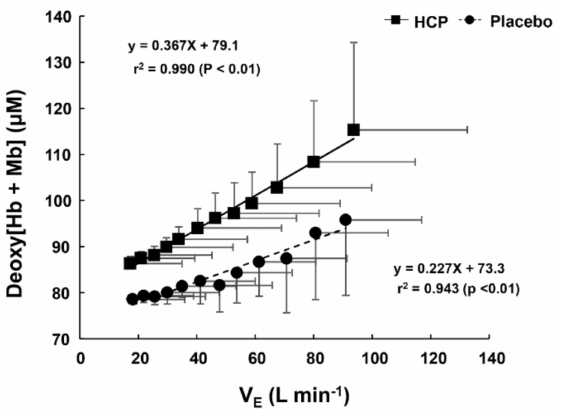
. Figure 4. The relationship between ventilation ( V E ) and the rectus femoris (RF) muscle deoxygenated hemoglobin and myoglobin concentration (deoxy[Hb + Mb]) profiles during cycle exercise in the . HCP and placebo groups. Note that the regression line for V E –deoxy[Hb + Mb] profiles’ relationship was steeper in the HCP group (slope = 0.367) than in the placebo group (slope = 0.227). Error bars: SD.